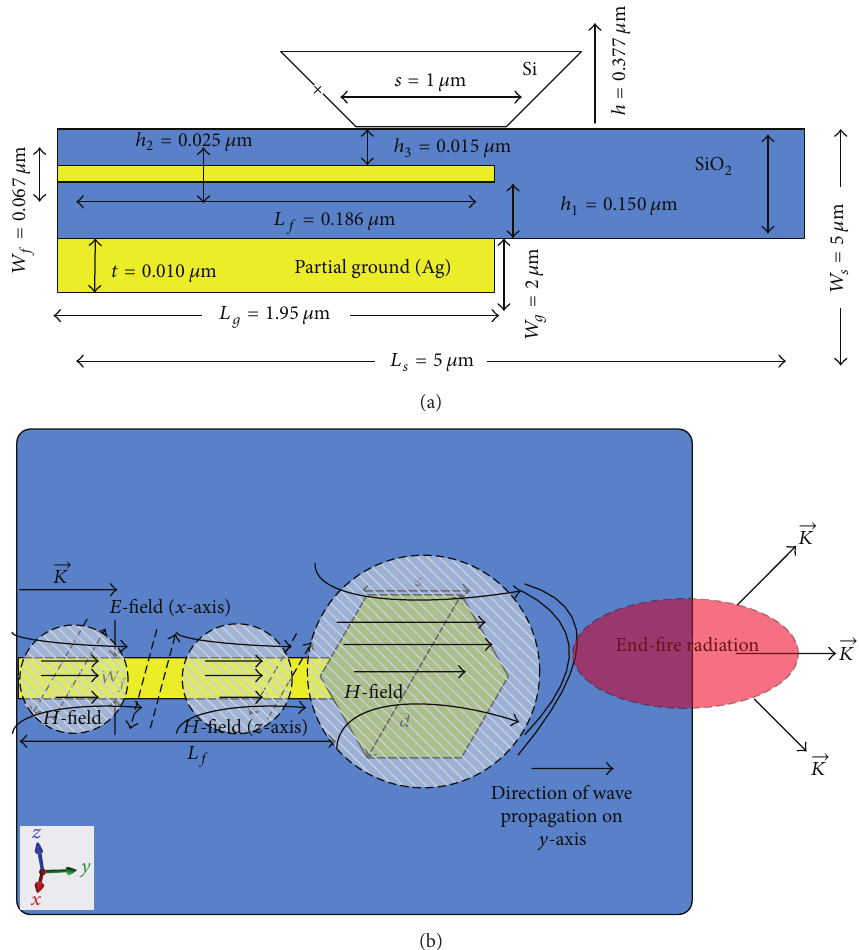
Figure 1: (a) Side view of proposed nantenna with relevant dimensions. (b) Top view of proposed nantenna. Propagation vector 𝐾 represents the optical power flowing along the 𝑦 -axis. The 𝐸 -field and 𝐻 -field lines are also shown in the 𝑥 - and 𝑧 -axis,